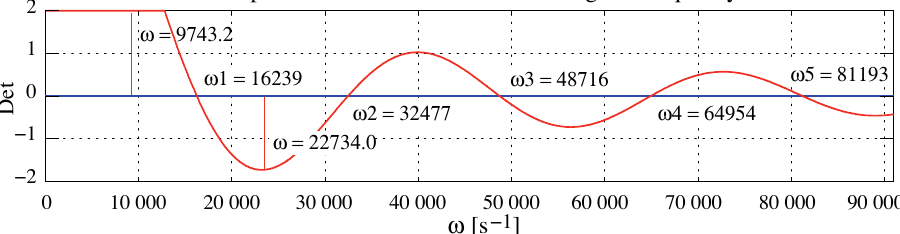
Fig. 6. Natural frequencies of the fixed-fixed bar.